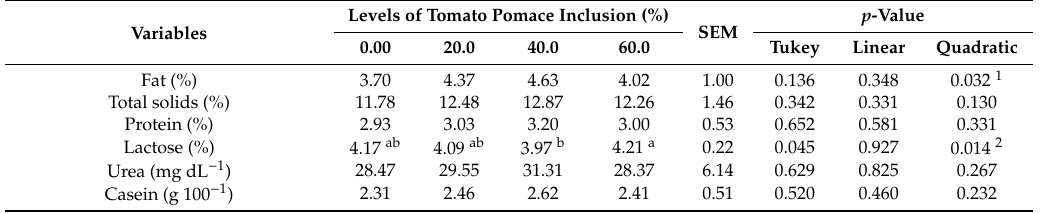
Table 4. Chemical composition of milk from dairy goats fed with di ff erent levels of inclusion of tomato pomace.